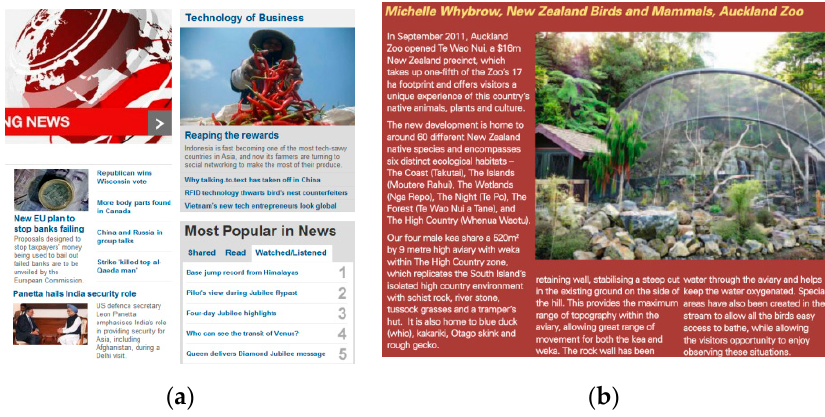
Figure 1. Two typical examples of the screen content images (SCIs) in the SIQAD database. ( a ) “cim 1” and ( b ) “cim19”.